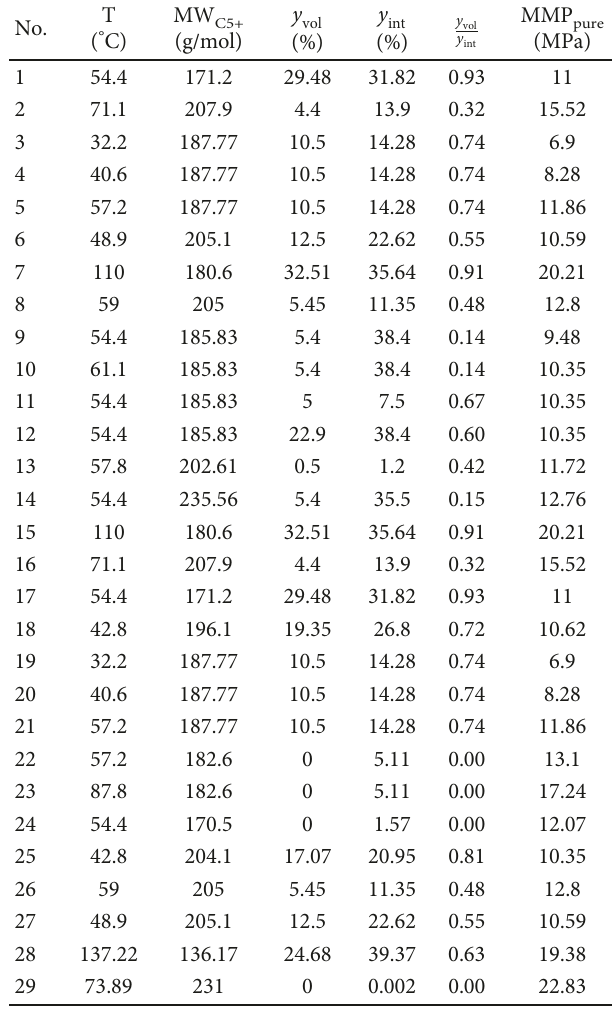
Table 4: Literature reported nonlight oil constituent and MMP [18].